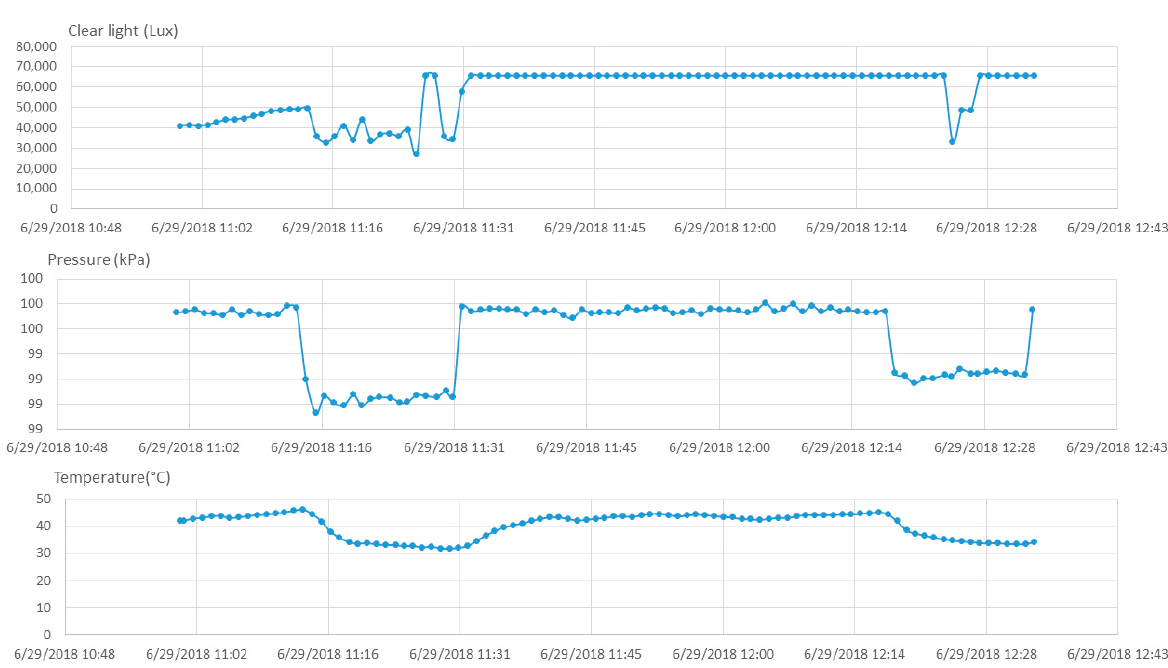
Figure 12. Exemplary atmospheric data collected by the bottom data logger on the DJI Matrice 600 Pro.